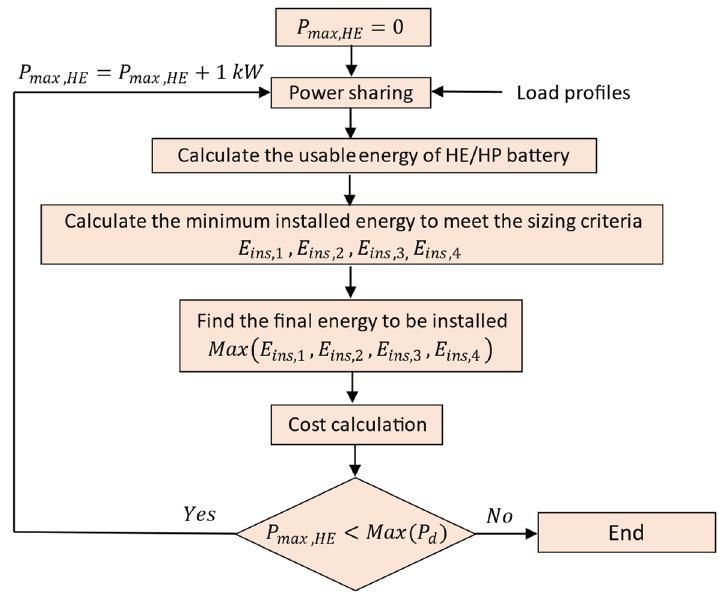
Figure 6. Sizing and cost assessment flow chart.